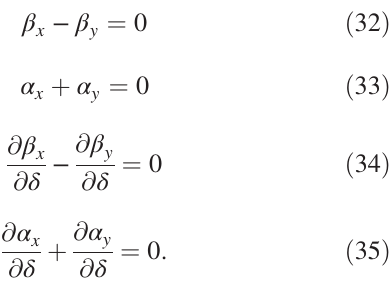
FIG. 4. Example A: PWFA staging optics, both using quadrupoles (a) and plasma lenses (b). Plots show size) vs beam line axis s , and chromatic dependence of α ð δ Þ and β ð δ Þ vs offset δ . Both solutions capture a 100 GeV beam exiting a plasma (with density ramps) matched to β 0 ¼ 32 . 5 cm and refocuses it back to 32.5 cm, with a 1 m drift space at the start and end for injection and extraction of drive beams. Solution (a) is a first-order apochromatic lattice using 8 quadrupoles with field gradient 160 T = m are placed antisymmetrically (mirrored with polarity switched), whereas solution (b) is a third-order apochromatic lattice using 7 discharge capillary plasma lenses [18] with field gradient 3000 T = m placed symmetrically. Transporting a beam with 1% rms energy spread leads to a projected emittance growth of 0.96% in lattice (a), and 0.000004% in lattice (b). Note the different δ -scales in the two chromatic dependence